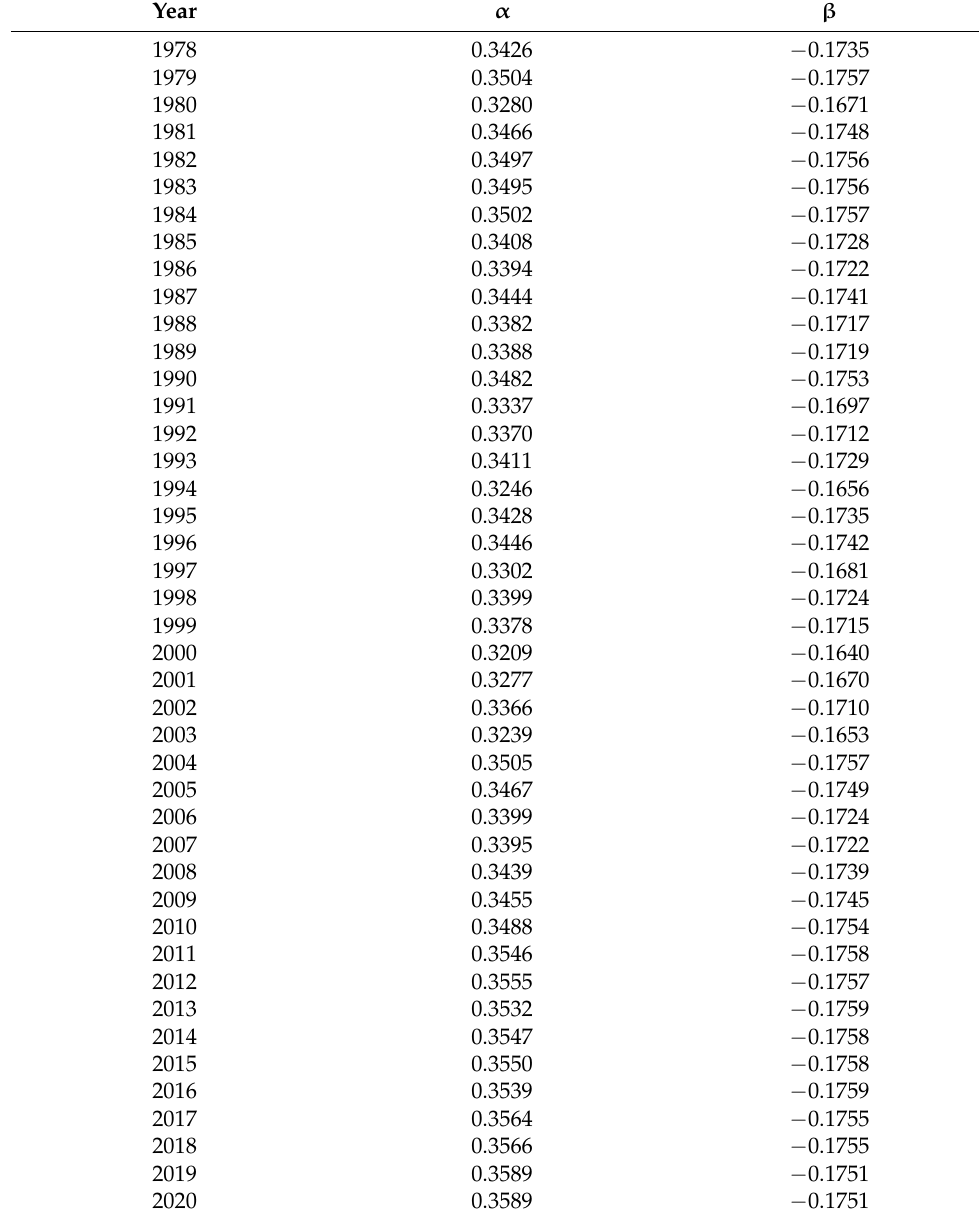
Table A1. The values of output elasticity of capital and labor from 1978 to